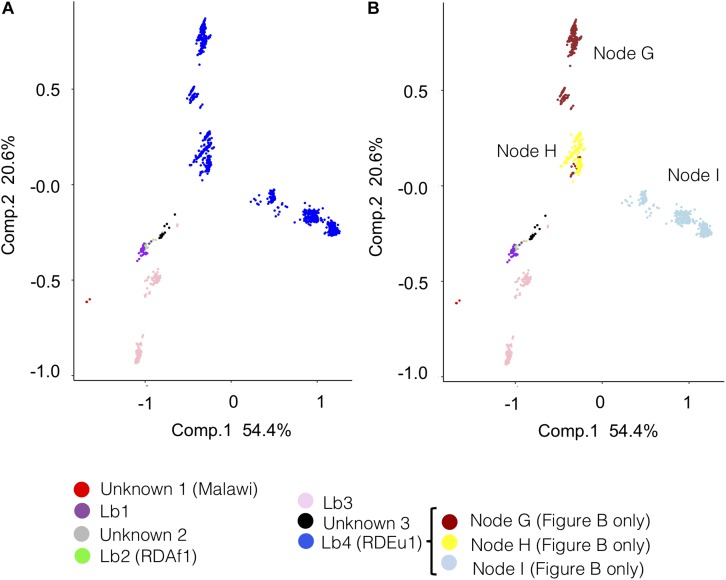
Principal component analysis (PCA) of Mycobacterium bovis lineages according to the reduced dataset (n = 1,201). The PCA graphs were constructed using the SNP (single nucleotide polymorphism) matrix of the 1,201 Mycobacterium bovis genomes. (A) PCA colored according to the proposed M. bovis lineages (Lb1, Lb2, Lb3, and Lb4) and unknown clusters (unknown 1, 2, and 3). (B) PCA colored according to the proposed lineages Lb1, Lb2, and Lb3, unknown clusters (unknown 1, 2, and 3) and clusters of M. bovis genomes emerging from nodes G, H, and I of Lb4 as depicted in the phylogenetic tree in Figure 2. The four inferred M. bovis lineages and unknown clusters are shown in purple – Lb1; green – Lb2; pink – Lb3; blue – Lb4; red – cluster unknown 1 (Malawi); gray – cluster unknown 2; black – cluster unknown 3. PCA analysis in 3 dimensions is shown in Supplementary Figure S5. PCA analyses using full dataset (n = 1,969) are shown in Supplementary Figures S6, S7.